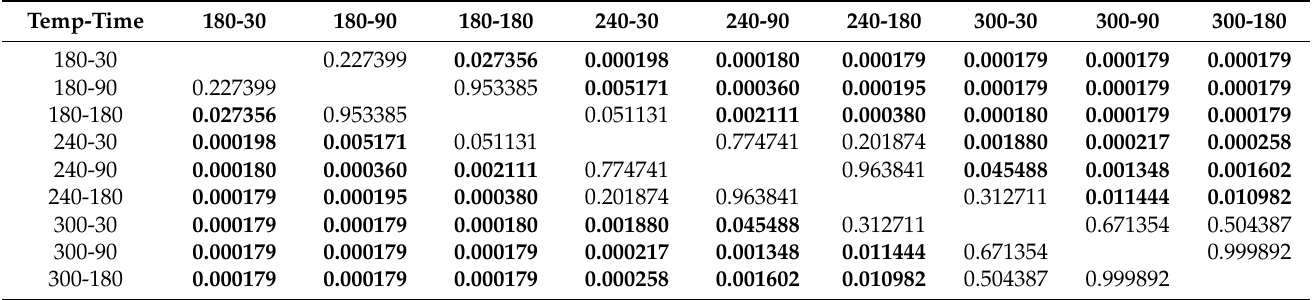
Table A11. Two-way analysis of variance (ANOVA) with post hoc Tukey test for C , a bold font signifies a statistically significant difference ( p < 0.05).